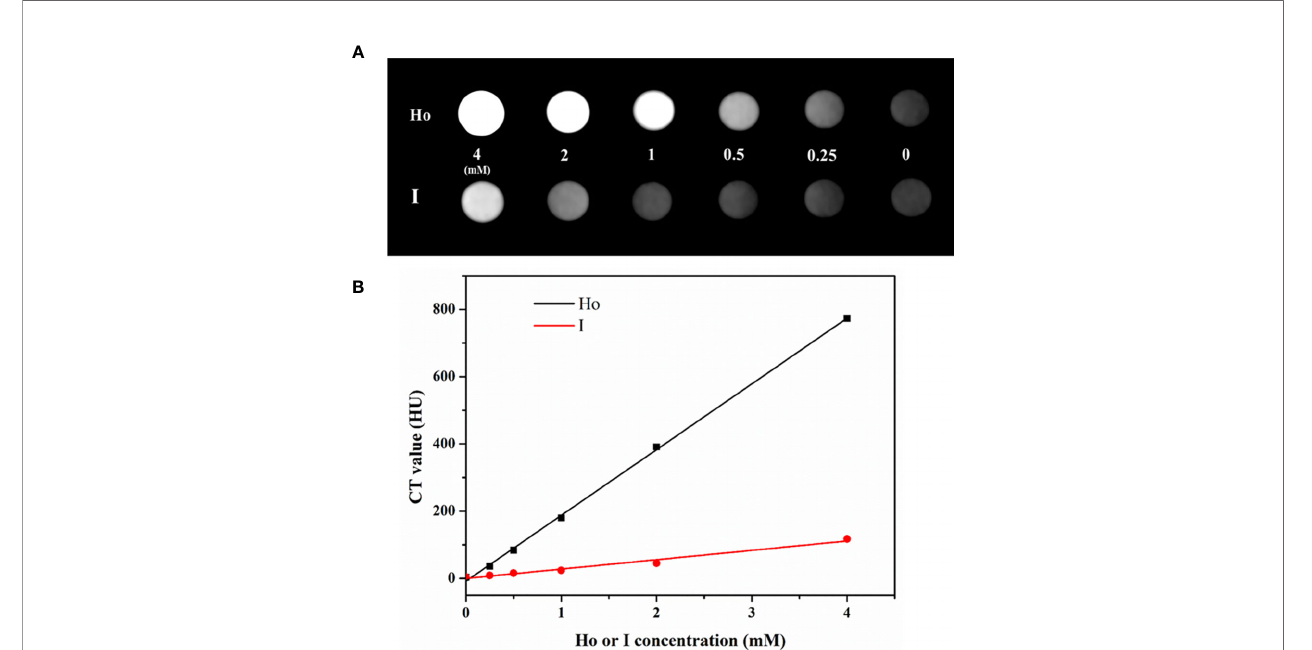
FIGURE 5 | (A) In vitro CT images of PEG-HoF 3 NPs and Iohexol aqueous solution with different concentration; (B) CT value of corresponding tube of A.